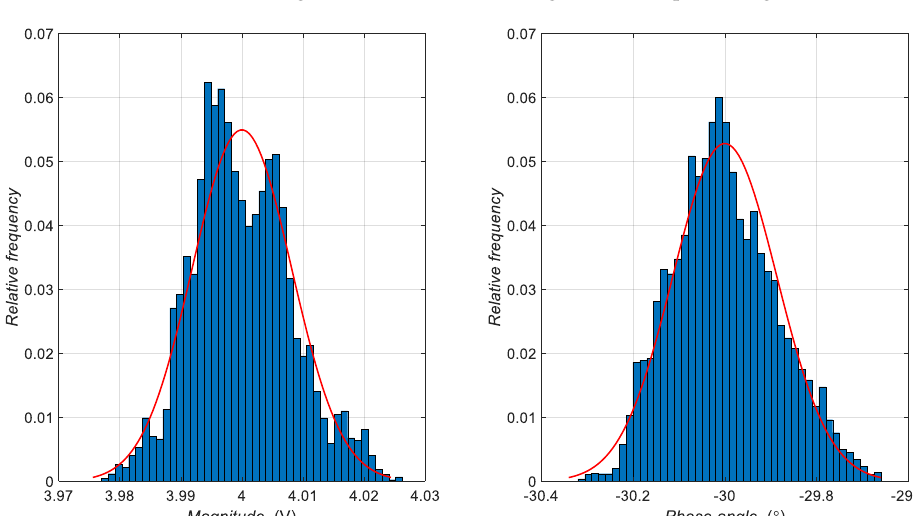
Figure 14. Histogram of 7th harmonic magnitude and phase angle.